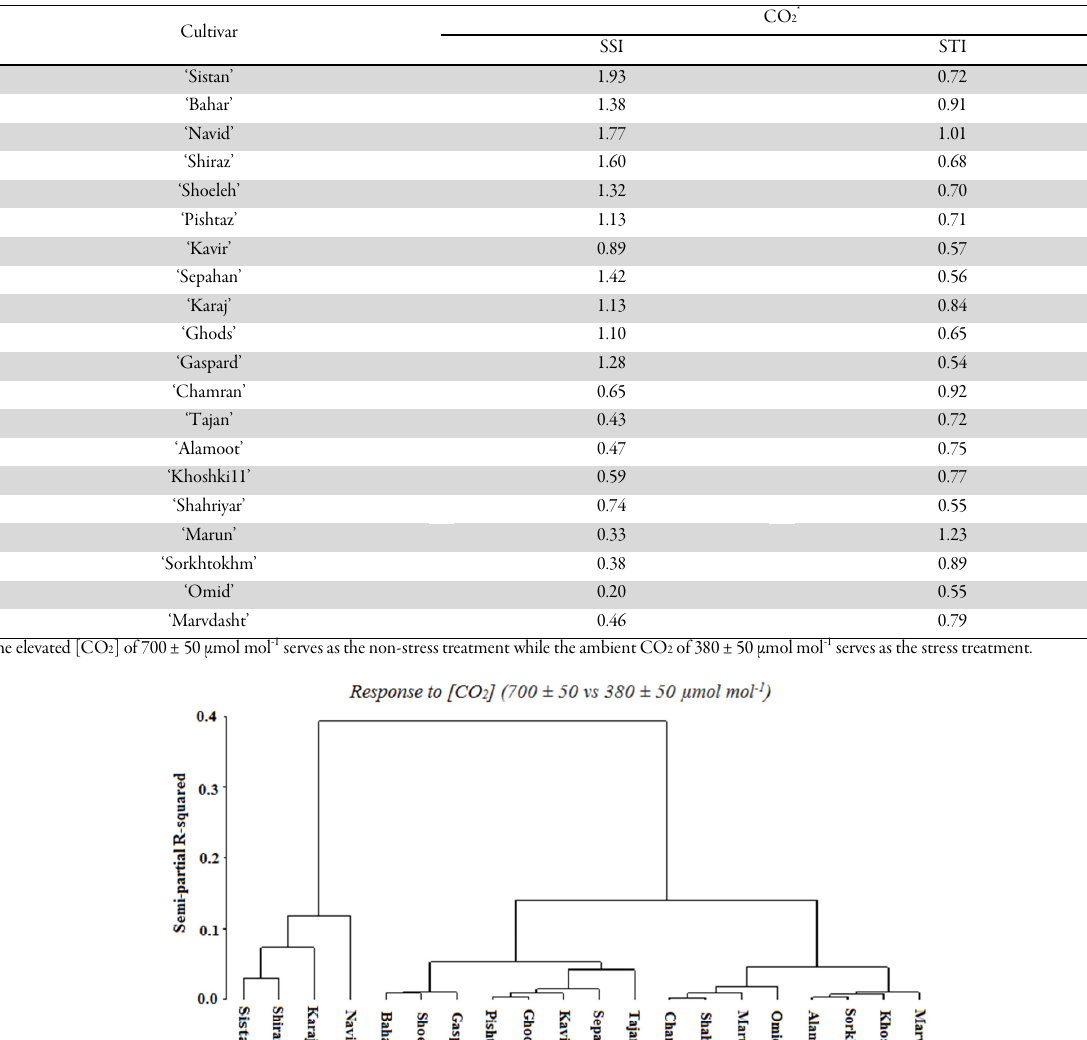
406 Table 6. Average values of SSI and STI in Iranian bread wheat cultivars. The values are based on total dry biomass (shoot plus root dry weights)